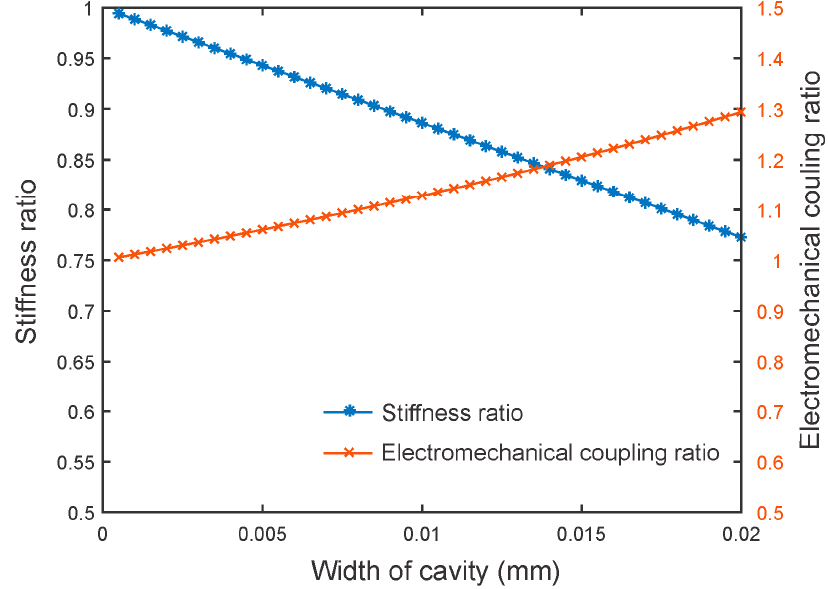
Figure 4. Stiffness ratio and electro-mechanical coupling ratio vs the width of the cavity.